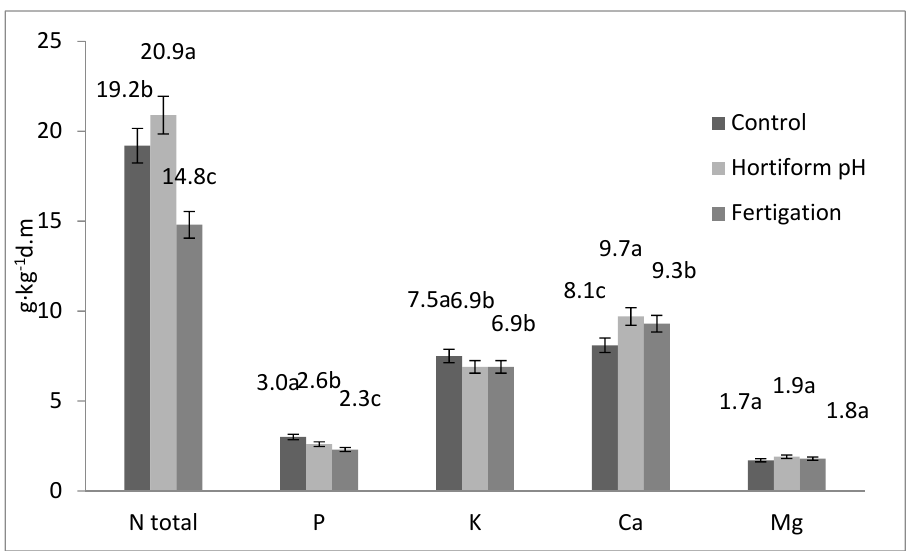
Figure 1. Influence type of fertilization on concentrations of N-total, P, K, Ca, Mg (g·kg − 1 d. m.) in leaves of azalea cv. ‘Anneke’. Mean from years. Results marked with the same letters are not significantly different.